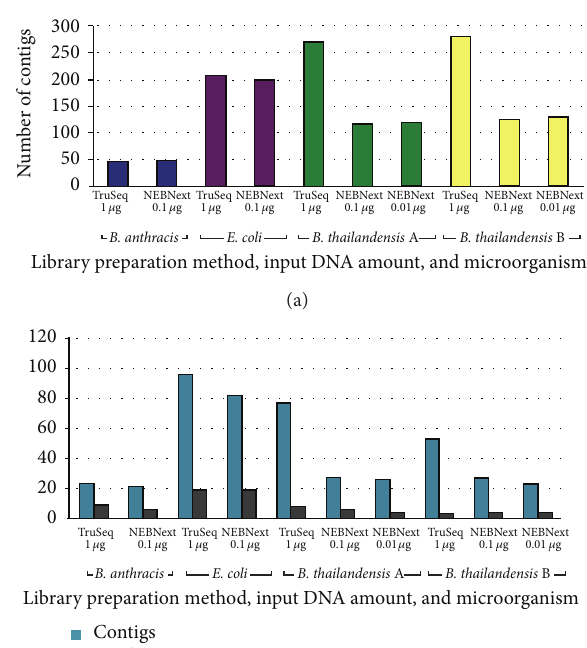
Figure 4: (a) IDBA assemblies of bacterial genomes using only Illuminashortinsertpaireddata.(b)Allpathsassembliesofbacterial genomes using Illumina short insert paired data and 454 long insert paired